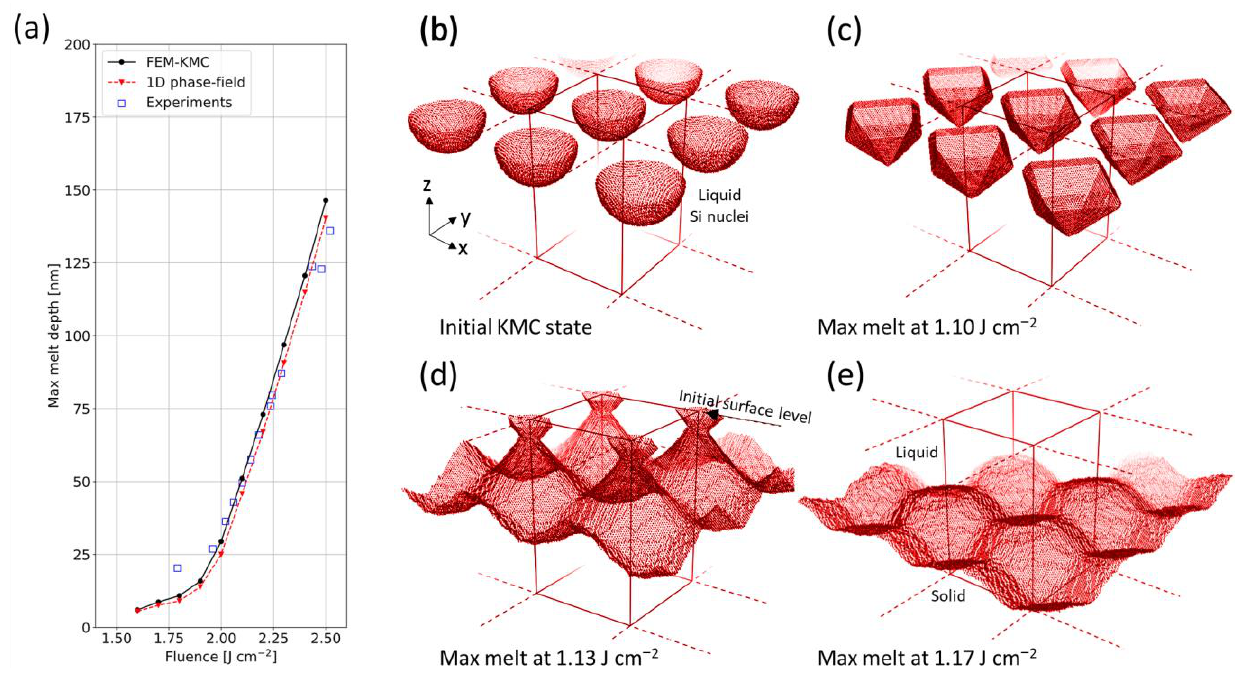
Figure 12. FEM-KMC simulations of Si(100) PLA. ( a ) FEM-KMC calculated maximum melt depth as a function of laser fluence for a PLA of Si(001) with a 308 nm and 160 ns laser pulse, in comparison with equivalent results from 1D phase-field simulations as well as experimental data. ( b ) Periodic visualization of a KMC box showing the solid–liquid interface (green), embedding the (initially hemispherical) liquid Si nano-droplet. ( c ) Reshaped nuclei at 1.10 J/cm 2 fluence at the time t MMV of maximum melt volume in the simulation (after 41 ns of irradiation). ( d ) Melting front at t MMV (37 ns) at 1.13 J/cm 2 , with nuclei partially coalesced. ( e ) Melting front at t MMV (32 ns) at 1.17 J/cm 2 , with nuclei completely coalesced into a rough molten layer.